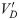
Conventional and alternative parameterizations capture the majority of polygenic genetic variance.Simulation is used to generate data sets with the additive (A), dominant (D), and additive by additive (AxA) genetic models and VA,
VD′ and VAA′′ are estimated using linear mixed models. The results are presented as the proportion of heritability explained by the genetic variance component; ha2 corresponds to VA (a), hd′2 to VD′ (b), and haa′′2 to VAA′′ (c).